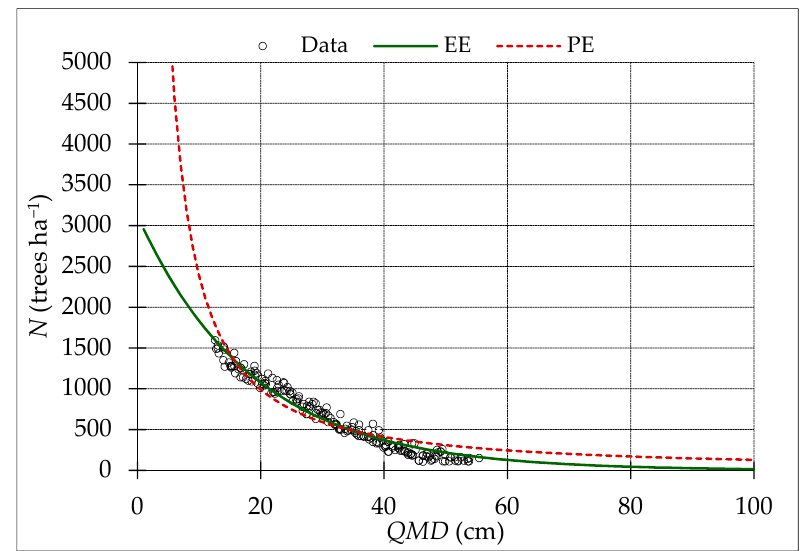
Figure 1. Maximum density lines fitted for all species combines of mixed-species plots. EE = the exponential equations (Equation (1)); PE = the potential equations (Equation (6)). Forests 2018 , 9 , x FOR PEER REVIEW